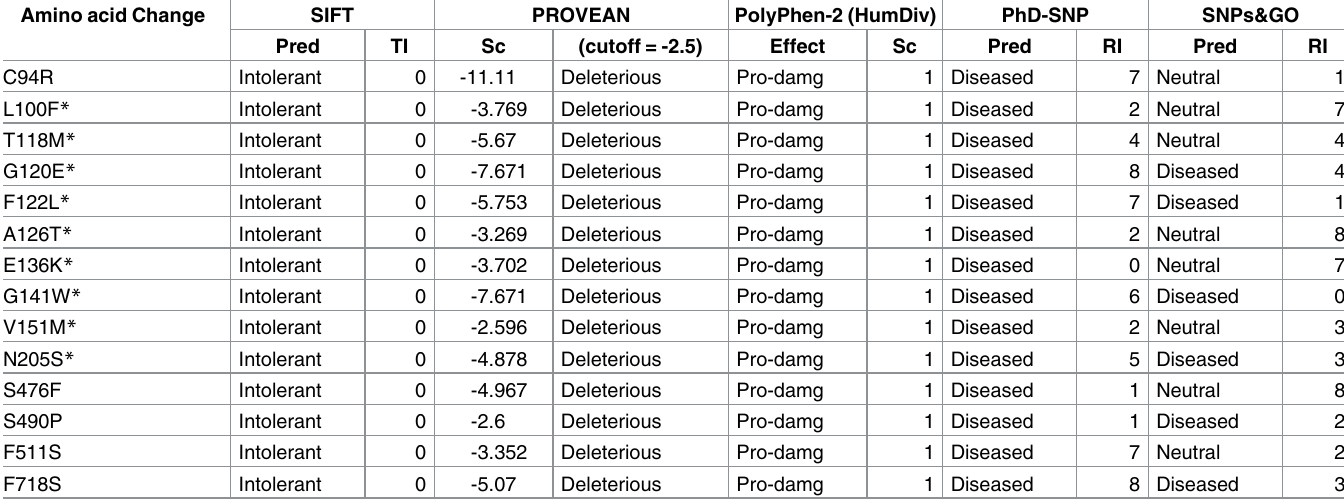
Table 1. High risk nsSNPs identified by five in silico programs.